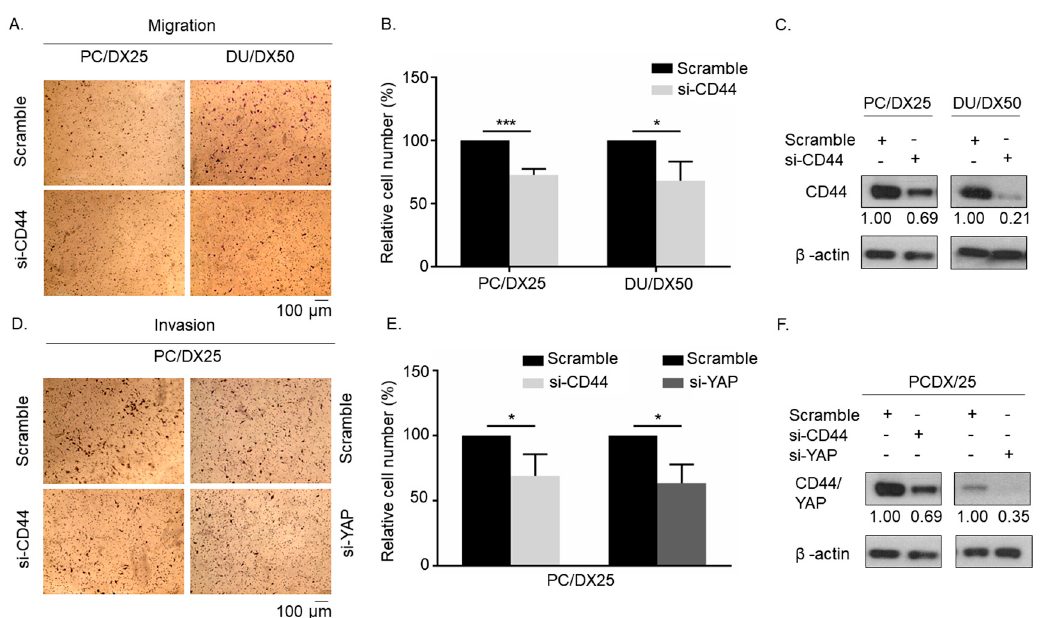
Figure 4. Knockdown of CD44 or YAP protein suppresses cell mobility of docetaxel-resistant PCa cells. ( A ) Migration of PC/DX25 and DU/DX50 cells with scramble control or CD44 siRNA knockdown was determined by transwell migration assay. ( B ) Quantification of cell migration of PC/DX25 and DU/DX50 cells with scramble control or CD44 siRNA knockdown in ( A ). ( C ) Confirmation of CD44 knockdown in PC/DX25 and DU/DX50 cells with Western blotting. ( D ) Invasion ability of PC/DX25 cells with CD44 siRNA knockdown or YAP siRNA knockdown was compared to PC/DX25 cells with scramble control using transwell invasion assay. ( E ) Quantification of cell invasion of PC/DX25 cells with or without CD44 siRNA knockdown or YAP siRNA knockdown in ( D ). ( F ) Confirmation of CD44 and YAP knockdown in PC/DX25 cells with Western blotting. Asterisks *, *** represent statistically significant difference of p value < 0.05, and p value < 0.001, respectively.